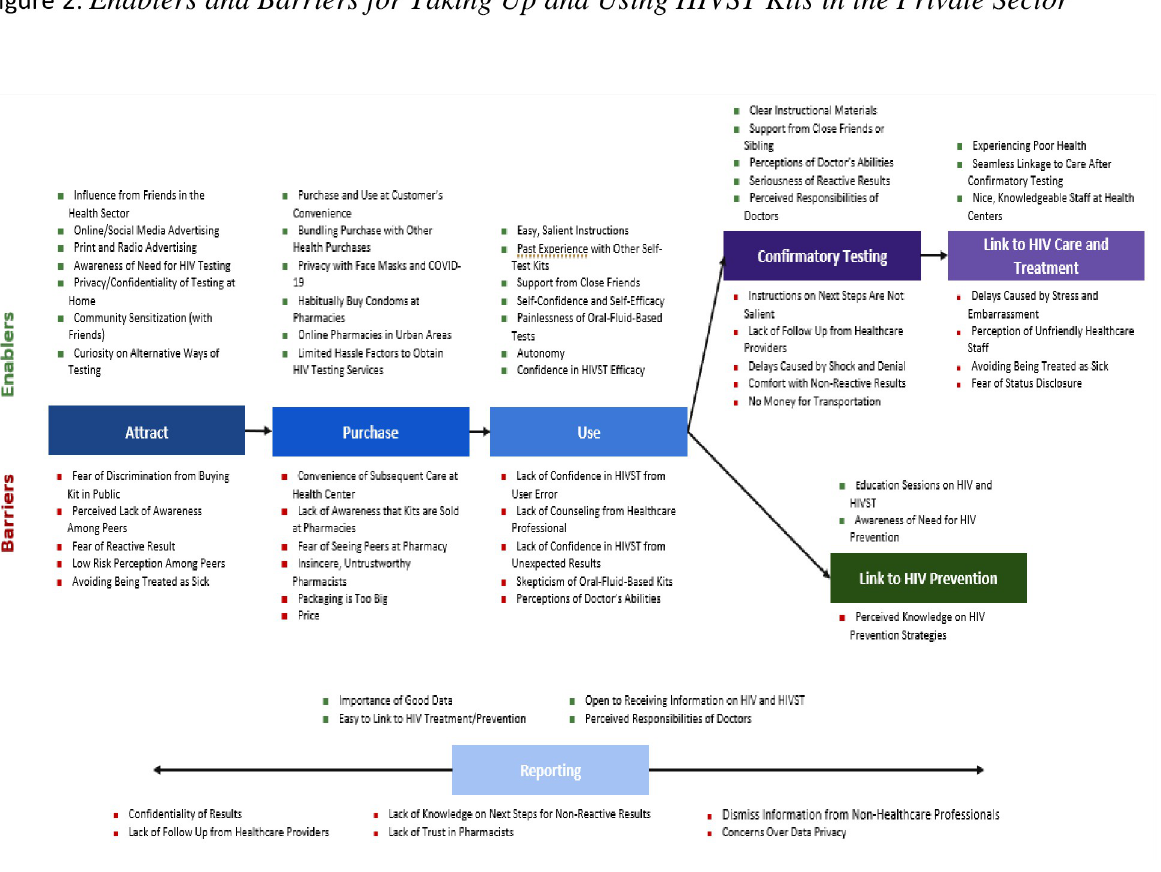
Fig 2. Enablers and barriers to taking up and using HIVST kits in the private